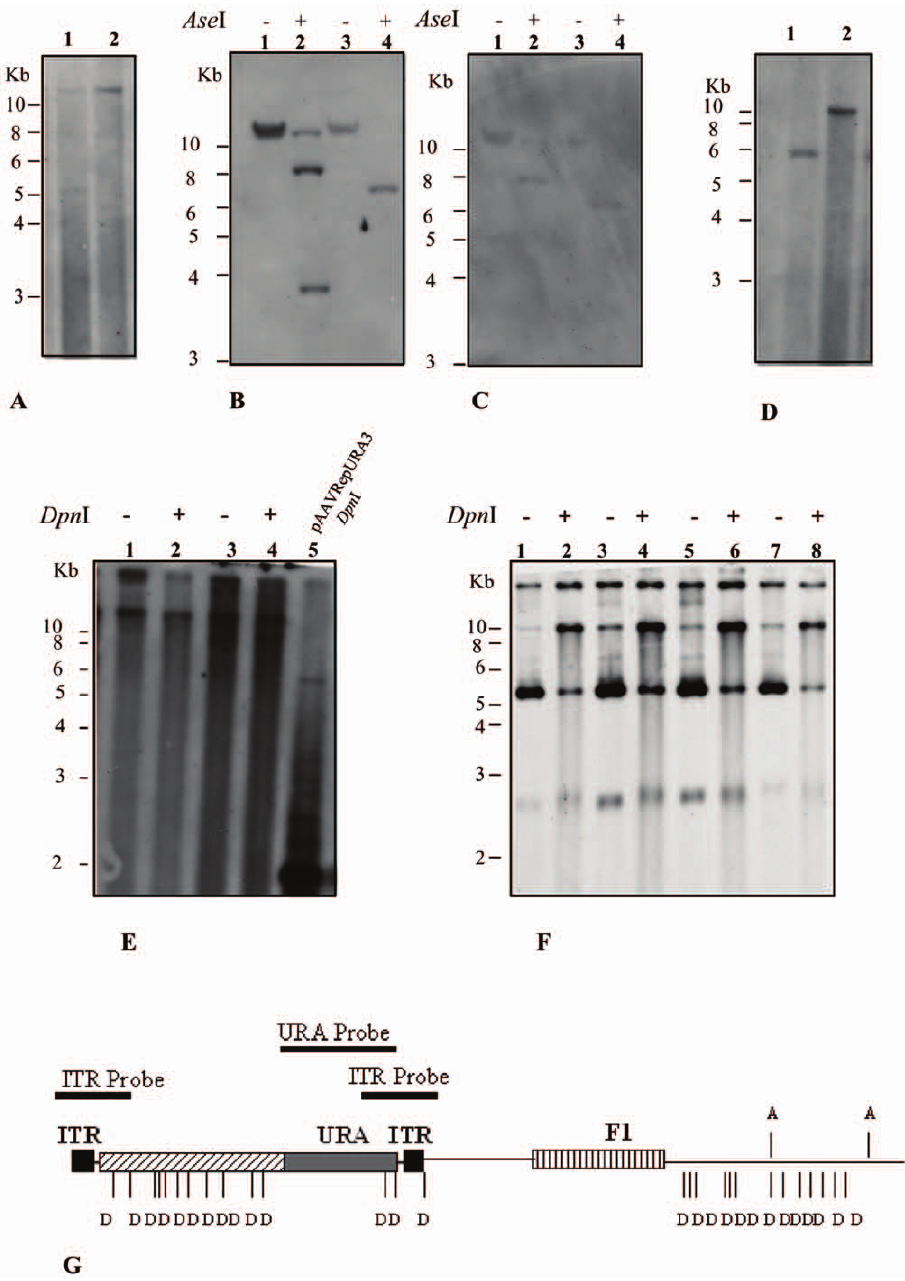
Figure 4. AAV replication in yeast. (A) Southern blot analysis of low M r DNA of two different yeast clones URA3 + (lane 1 and 2) derived from transformation with pAAVRepURA3 using the URA3 marker gene as probe. (B, C) Southern blot analysis of genomic DNA of the same two clones as in B undigested (lane 1 and 3), and digested with Ase I (lane 2 and 4) probed with URA3 (B) or ITR probe (C). (D) Low M r DNA of the two yeast clones URA3 + LEU2 + derived from transformation with pAAVRepURA3 and successively transformed with pG.Rep68 (lane 1 and 2) analyzed on Southern Blot using the URA3 probe. (E) Low M r DNA of yeast clones URA3 + LEU2 + derived from co-transformation of pAAVRepURA with control plasmid pGAD424. Lanes 1 and 3 show the undigested DNA and lanes 2 and 4, DNA digested with Dpn I and subjected to Southern blot analysis using URA3 marker gene as probe. Lane 5 shows the result of Dpn I digestion of the pAAVRepURA plasmid. Dpn I was performed in order to demonstrate that AAV DNA replicated in yeast. (F) Low M r DNA of yeast clones URA3 + LEU2 + derived from co-transformation of pAAVRepURA with plasmid pG.Rep68. Lanes 1, 3, 5, 7 show the undigested DNA and lanes 2, 4, 6, 8 DNA digested with Dpn I and subjected to Southern blot analysis using URA3 marker gene as probe. (G) Schematic representation of Dpn I/ Mbo I (indicated with D) and Ase I (indicated with A) restriction map of pAAVRepURA plasmid. The Dpn I/ Mbo I restriction endonucleases do not cut in the URA3 gene.